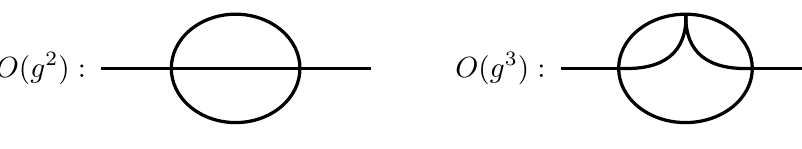
Figure 5 . Perturbative corrections to the 1-particle mass at O ( g 2 ) , given by eq. (2.1), and O ( g 3 ) , eq. (4.3), in LC quantization. Both corrections only involve three-particle intermediate